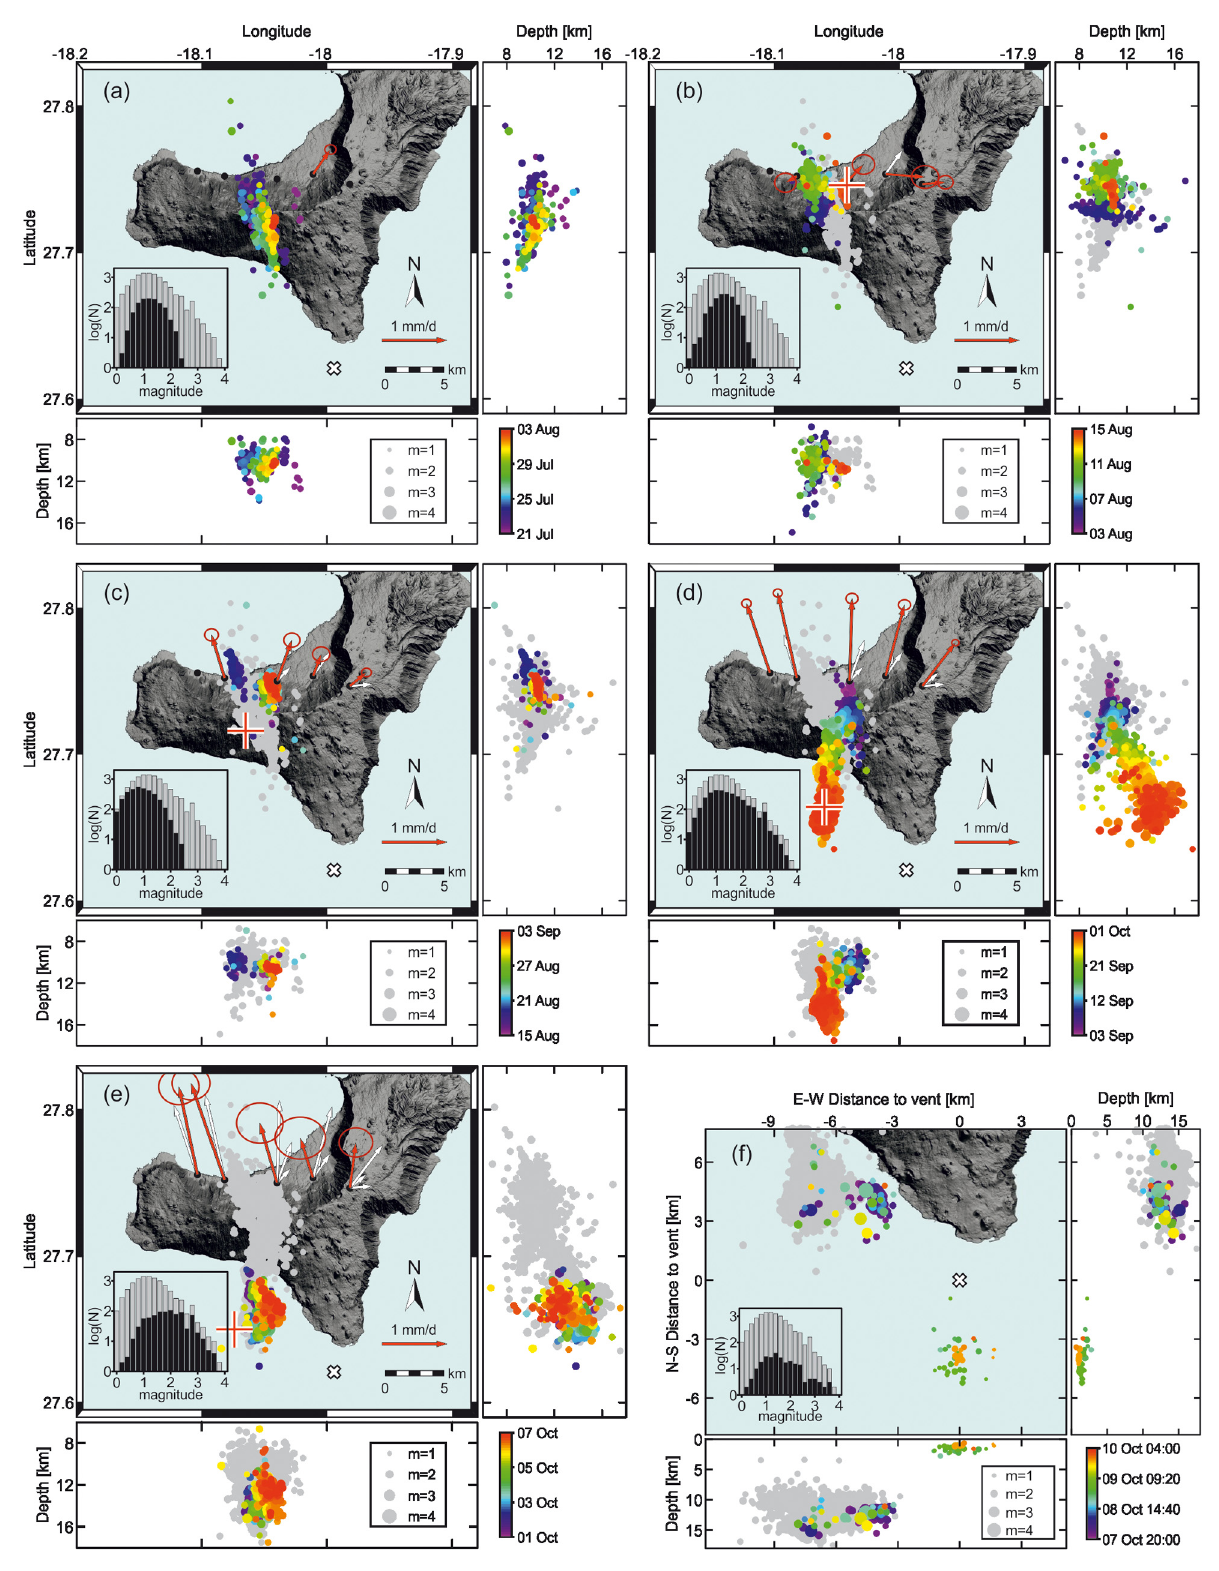
Figure 4. Temporal evolution of the latitude, longitude and depth (km) of the earthquakes with magnitude >1.5 (time scale of events is re- ported in the color bar and in grey are reported the earthquakes occurred during the previous phases) along with the evolution of the hor- izontal deformation registered by GPS stations (red arrow for the period in analysis and white arrow for the previous periods) during the pre-eruptive phase of 2011-2012 eruption of El Hierro Island. In grey are reported the earthquakes occurred in the previous phases. Red cross indicates the position of the deformation source according to Mogi model and white X marks the vent of 2011-2012 eruption. Inner plots give the histograms of the number of located events versus magnitude for the each phase (black) and for the full period (grey shaded). Seis- mic data are after relocation of Domínguez Cerdeña et al.